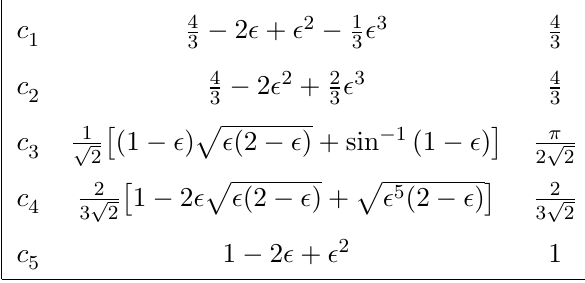
Table 2 . Constant coe(cid:14)cients in the density matrices after cos (cid:18) integration; see eqs. (3.15) and (3.19). The last column gives the values for (cid:15) = 0. The allowed region